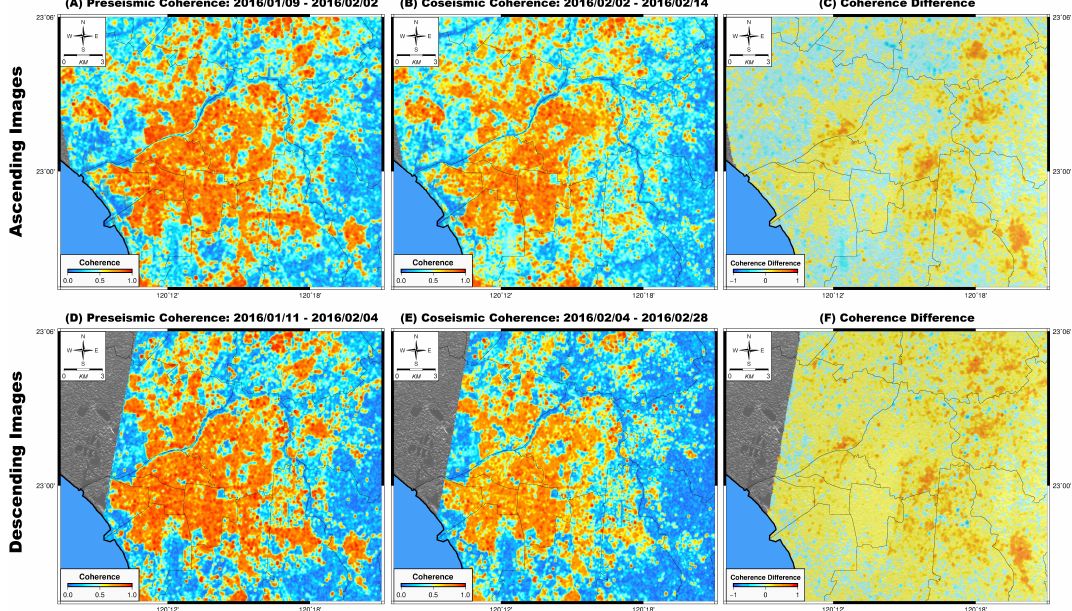
Figure 4. The coherence difference obtained from the preseismic and coseismic image pairs. The subfigures show the preseismic coherence, coseismic coherence and their coherence difference obtained by using ascending image pairs ( A – C ) and descending image pairs ( D – F ). In (A,B,D,E), the value of the coherence color bar is from 0–1, and the warm color represents a high correlation value. However, the color bar for coherence difference in (C,F) is from − 1–1, and the warm color indicates the decrease of a coherence value from the preseismic image pair to the coseismic image pair. Table 2. The information of background image pairs for ascending orbits. Pair